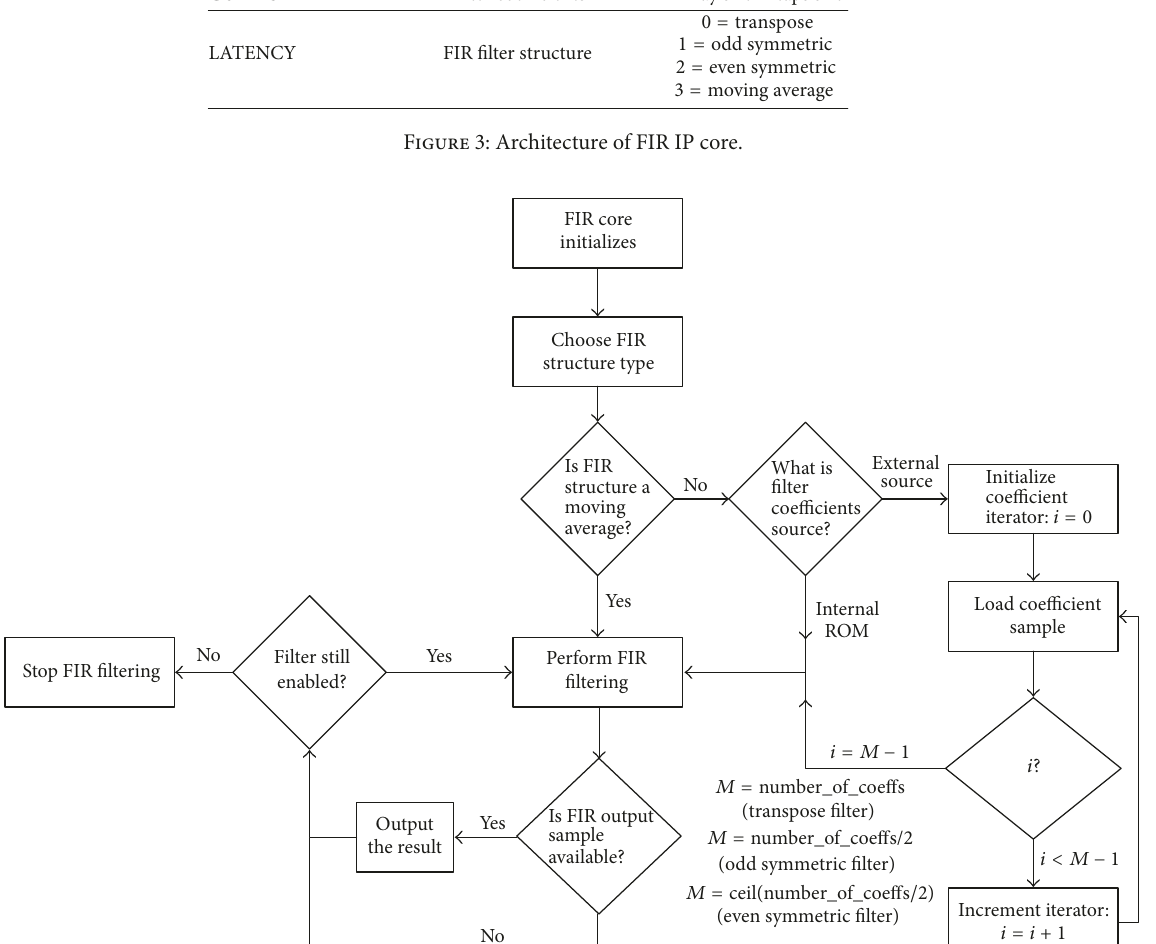
Figure 4: FIR core data flow